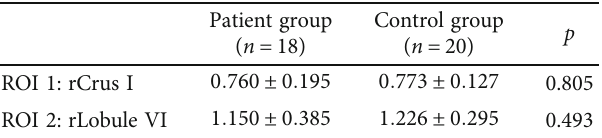
Figure 3: The MNI coordinates of the peak t -value from regions with signi fi cant between-group di ff erences in VBM analysis were extracted as the center of ROI. ROI 1 (36, -67.5, and -36): rCrus I; ROI 2 (22.5, -69, and -22.5): rLobule VI. Table 3: Between-group di ff erences in ALFF within ROI 1 (rCrus I) and ROI 2 (rLobule